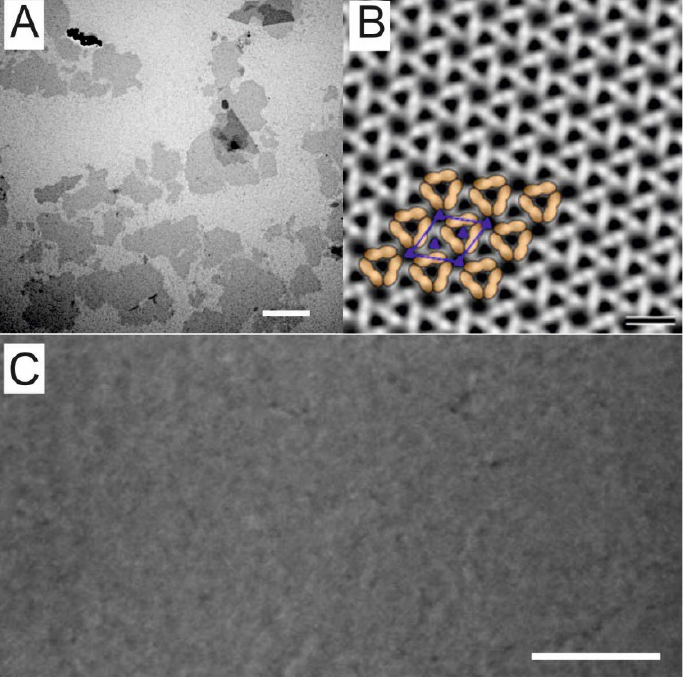
Figure 3. ( A ) Transmission electron micrograph of Saccharolobus solfataricus P2 (SSO) fragments after sonication. Bar, 1000 nm; ( B ) computer image reconstruction (2D projection) of the p3-ordered hexagonal S-layer lattice from SSO. Shown are a unit cell and the corresponding three-fold axis of rotation (symmetry operators) in blue. The protein is light, the pores are dark. In addition, a possible configuration of proteins belonging to a unit cell is shown by strokes drawn by hand in orange. Bar, 20 nm; ( C ) scanning electron micrograph of SSO fragments deposited on microfilter 1 (100,000× magnification). Bar, 500 nm.